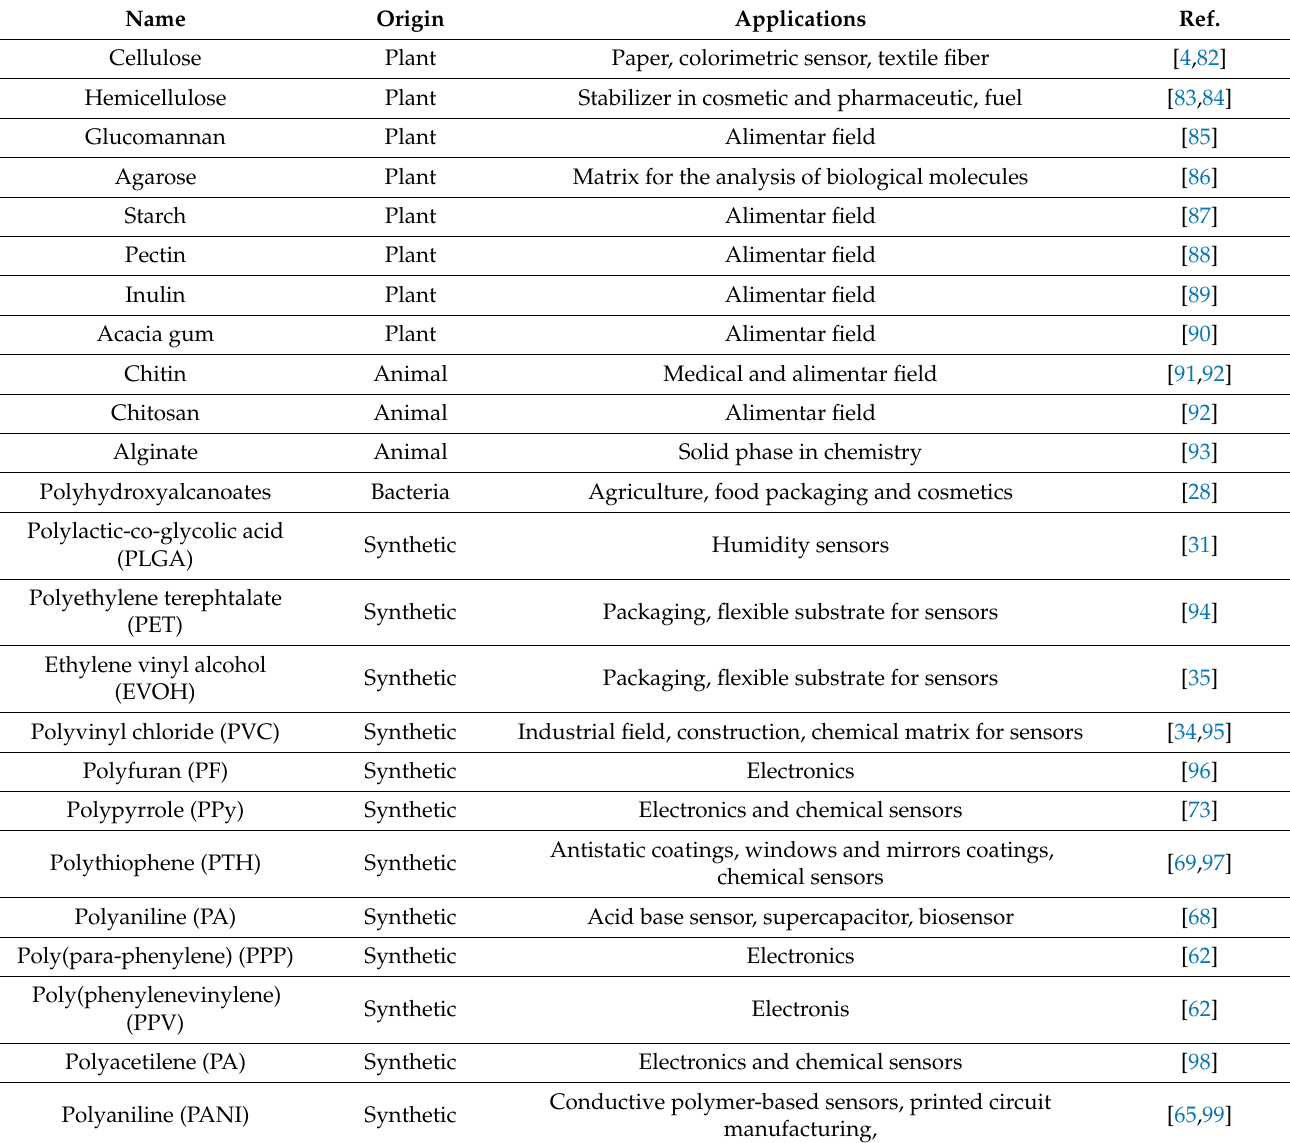
Table 1. Name, origin and applications of the natural and synthetic polymers used for preparing the sensors described in this